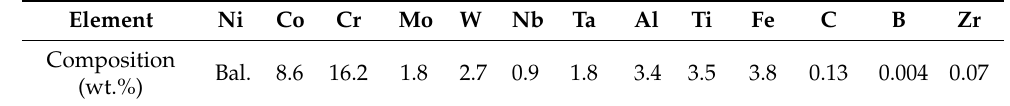
Table 1. Chemical composition of IN738LC powder.